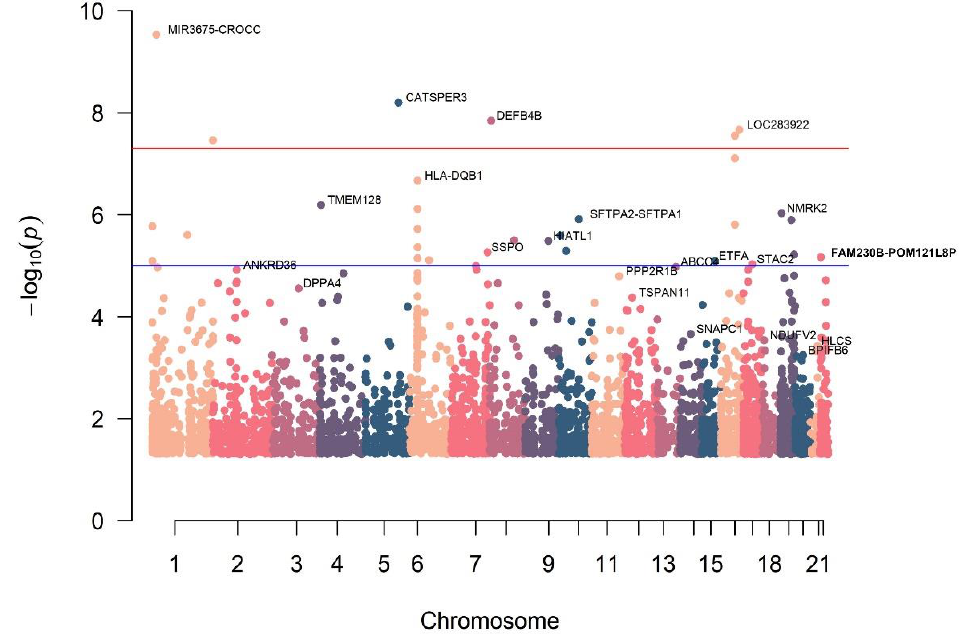
Figure 1. Manhattan plot of the results from the GWAS analysis of RC. The –log 10 p values for association with RC tear for 5638 SNPs from GWAS are plotted by genomic position with chromosome number listed across the bottom. The y-axis shows the –log 10 p values for association with RC tear. SNPs with the lowest p values in each chromosome are annotated with the nearest gene name. Red line represents the genome-wide significance threshold* of p -value = 5.00 × 10 − 8 , while the blue line corresponds to the suggestive threshold † of p -value = 1.00 × 10 − 5 . All data met genome-wide significance criteria with a p -value of less than 0.05. * Ref. [16]; † Ref. [17].